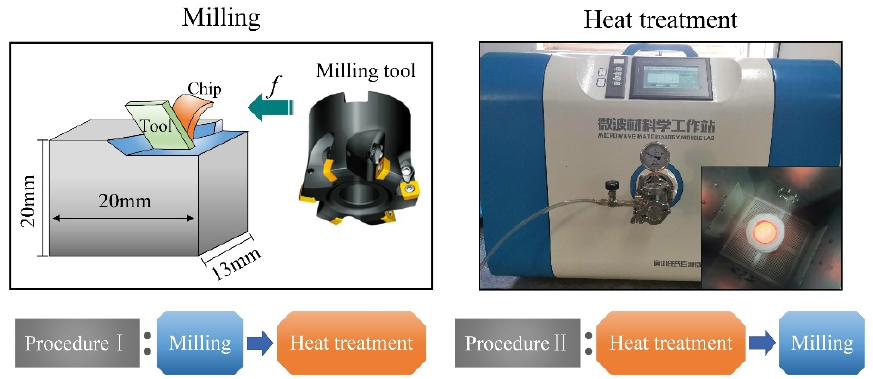
Figure 2. Sequential processes of manufacturing the GH4169 workpiece. Table 2. Sample nomenclature.